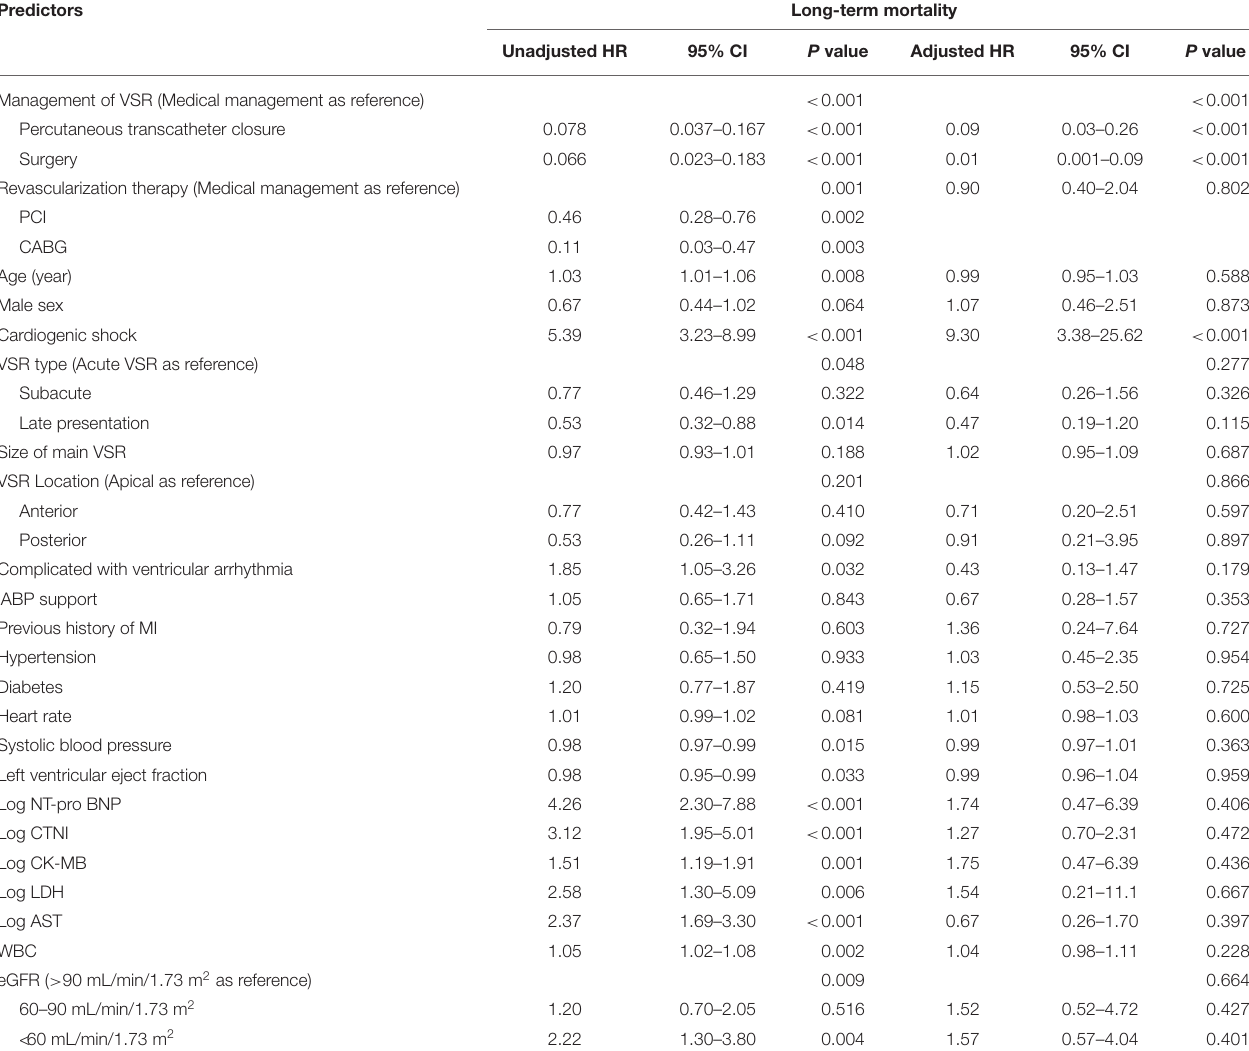
TABLE 3 | Independent risk factors of long-term